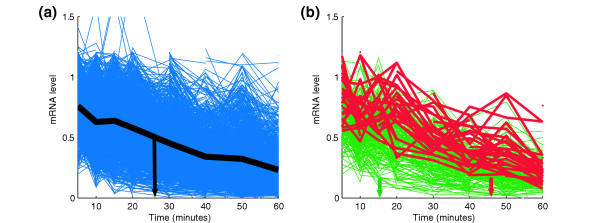
Decay profiles of the entire genome and of genes regulated by a stability and a de-stability motif. (a) Decay profile of the entire genome; the black curve shows the genome average profile. (b) Decay profiles of the target gene set of the destabilizing motif M1 (green), which has a mean half-life of 16 mins, and the stabilizing motif M11 (red), which has a half-life of 46.5 mins. The mean half-lives are marked by arrows. Expression data profiles, as well as half-lives computed using a fit to an exponential function, are from Wang et al. [14].